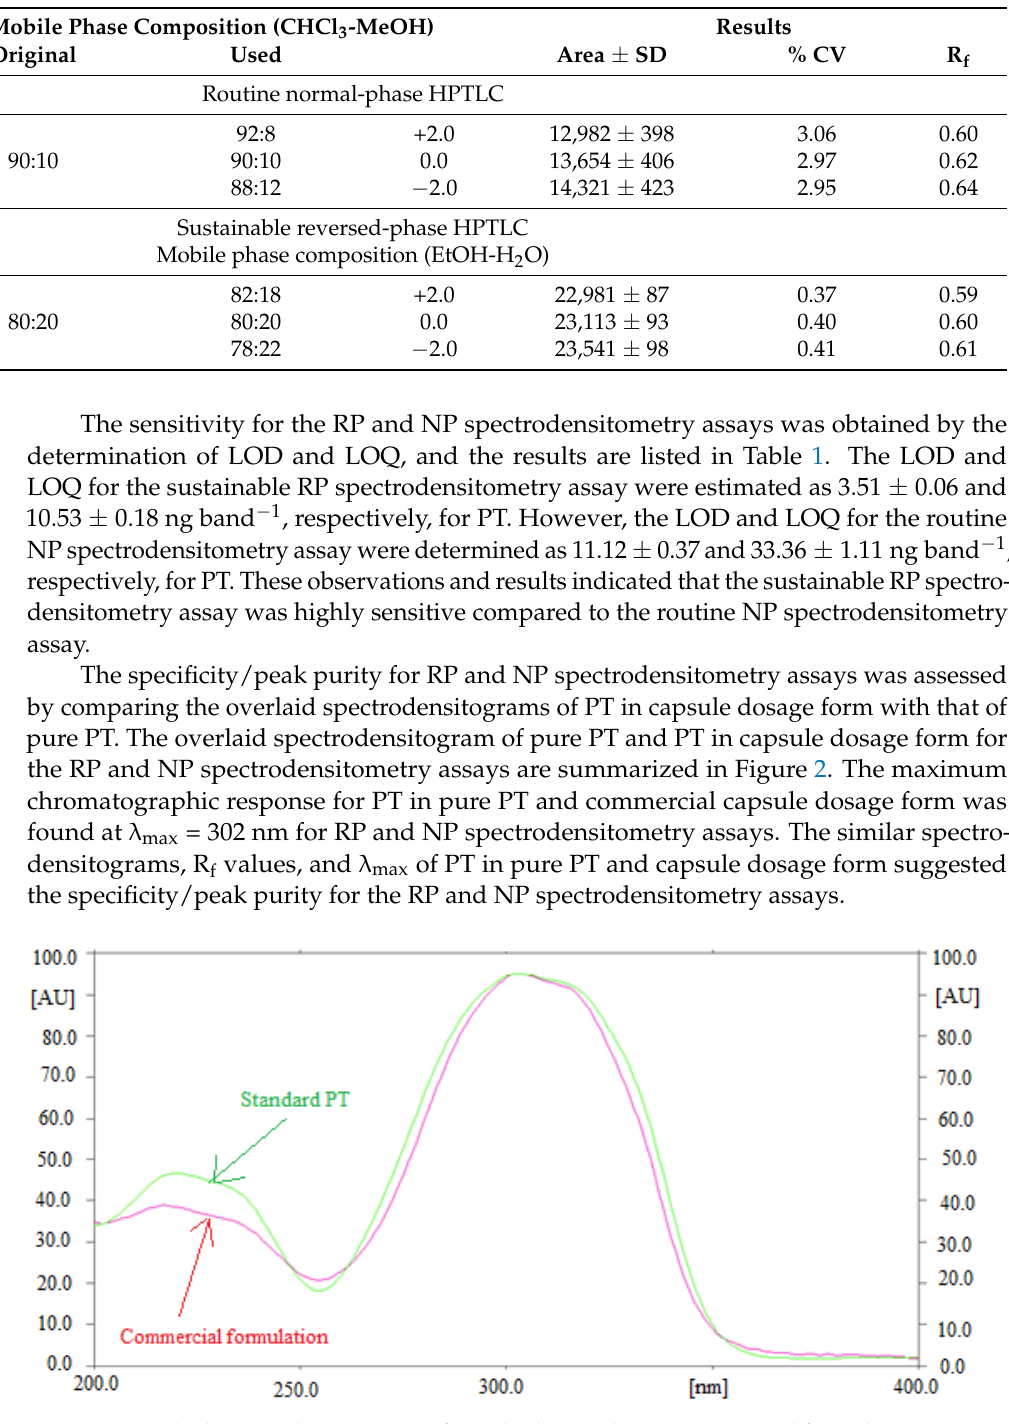
Figure 2. Overlaid spectrodensitograms of standard PT and PT in commercial formulation.